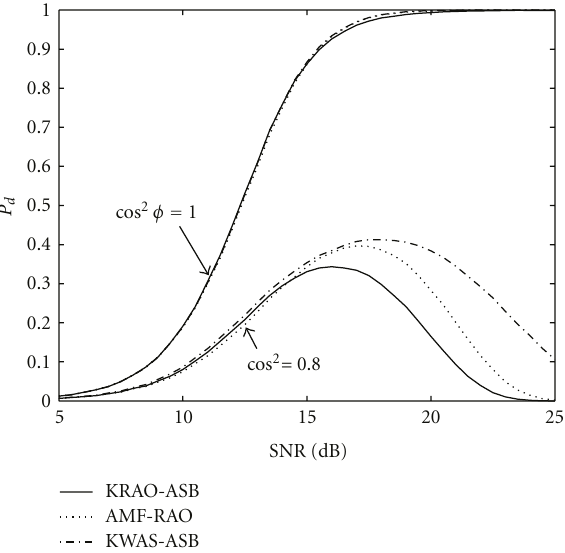
Figure 7: Matched P d versus SNR for the KRAO-ASB, the KRAO, and the AMF with N = 8, K = 24, and ρ = 1 . 2.